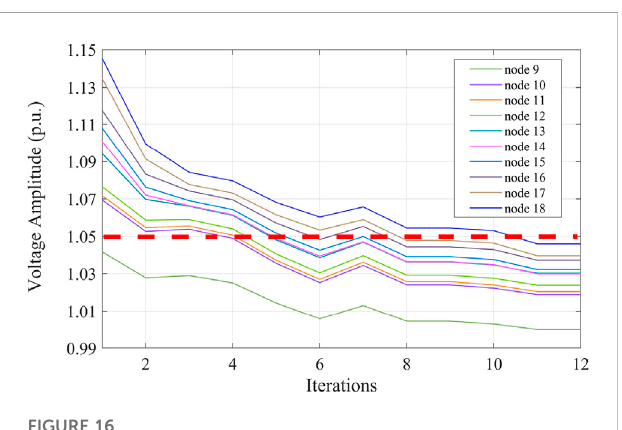
FIGURE 16 Voltage control effects of the PSO algorithm.